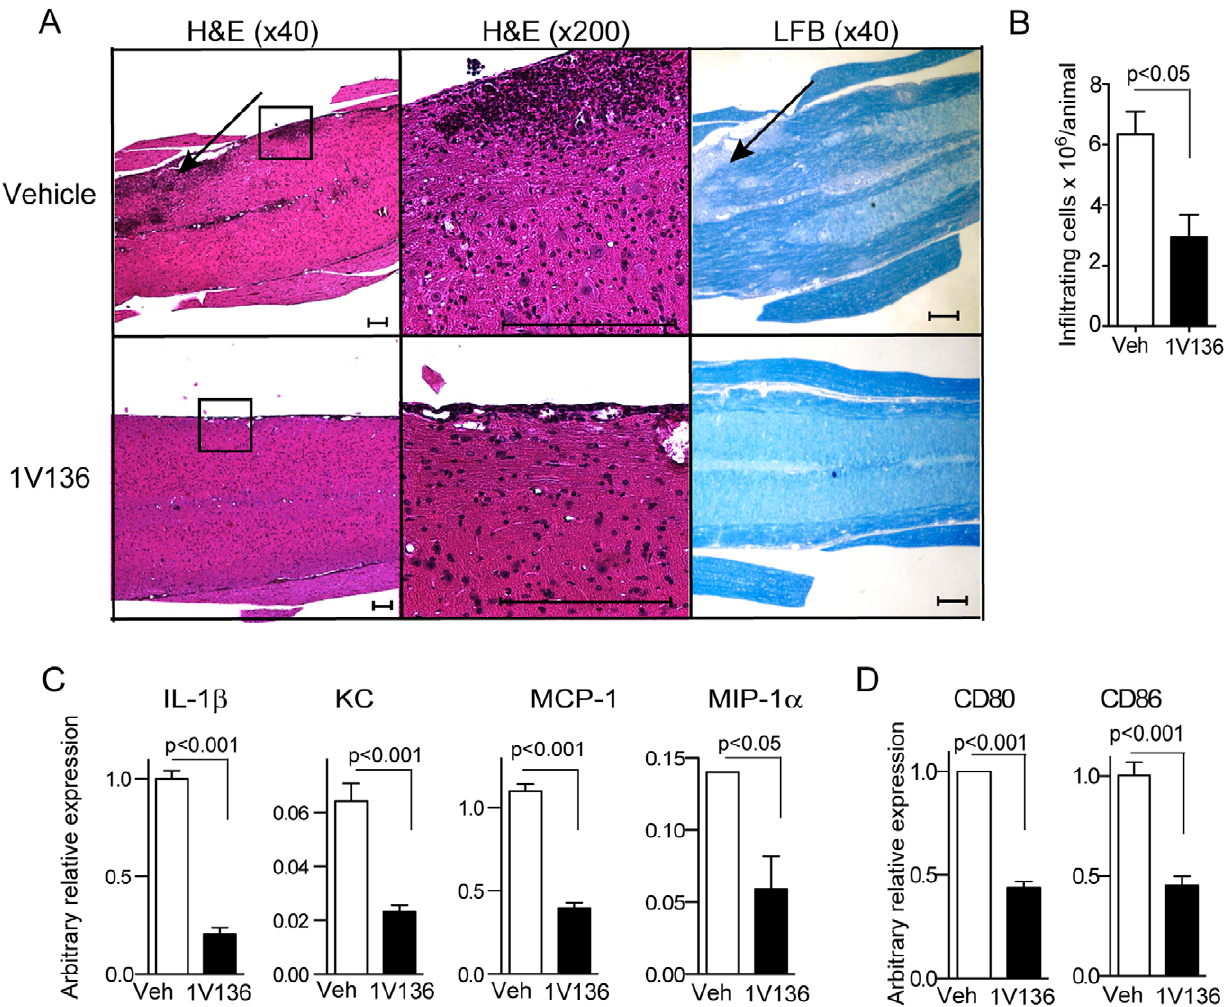
Figure 4. TLR7 ligand treatment reduced spinal cellular infiltration, and spinal chemokines and cytokines of EAE mice. (A) Representative sagittal sections of lumbar spinal cords from vehicle-treated or 1V136-treated EAE mice. H&E stained sections are shown in the left panels ( 6 40 original magnification) and the insets are shown at higher magnification (middle panels, 6 200 original magnification). Areas of demyelination are indicated by the arrows in the LFB stained sections (right panels). Scale bars:100 m m. (B) The total number of infiltrating cells isolated from pooled spinal cords from vehicle-treated (Veh) or 1V136-treated (1V136) EAE mice (n=5/group). The data shown are averages of three independent experiments 6 SEM. p , 0.05 by Student t test. (C) 1V136 treatment reduced chemokine expression in the spinal cords in the EAE mice. Chemokine expression levels in the spinals cords were reduced in 1V136-treated EAE mice. RNA was extracted from pooled spinal cord samples collected from 1V136-treated (n=4) or vehicle-treated (n=4) mice. mRNA levels of IL-1 b , KC, MCP-1 or MIP-1 a were analyzed by qPCR methods. The data were normalized to 18S ribosomal RNA gene and are presented as arbitrary units. p , 0.05 by Student t test. Data shown are representative of two independent experiments that exhibited similar results. (D) The levels of CD80 and CD86 mRNA transcripts were also reduced in the spinal cords of 1V136 treated mice. Data are presented as arbitrary units as normalized to GAPDH. p , 0.05 by Student t test.